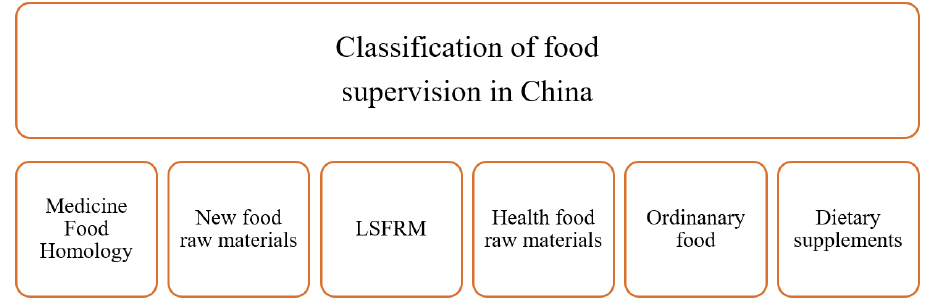
Figure 5. NHC’s classification of different types of food regulation.